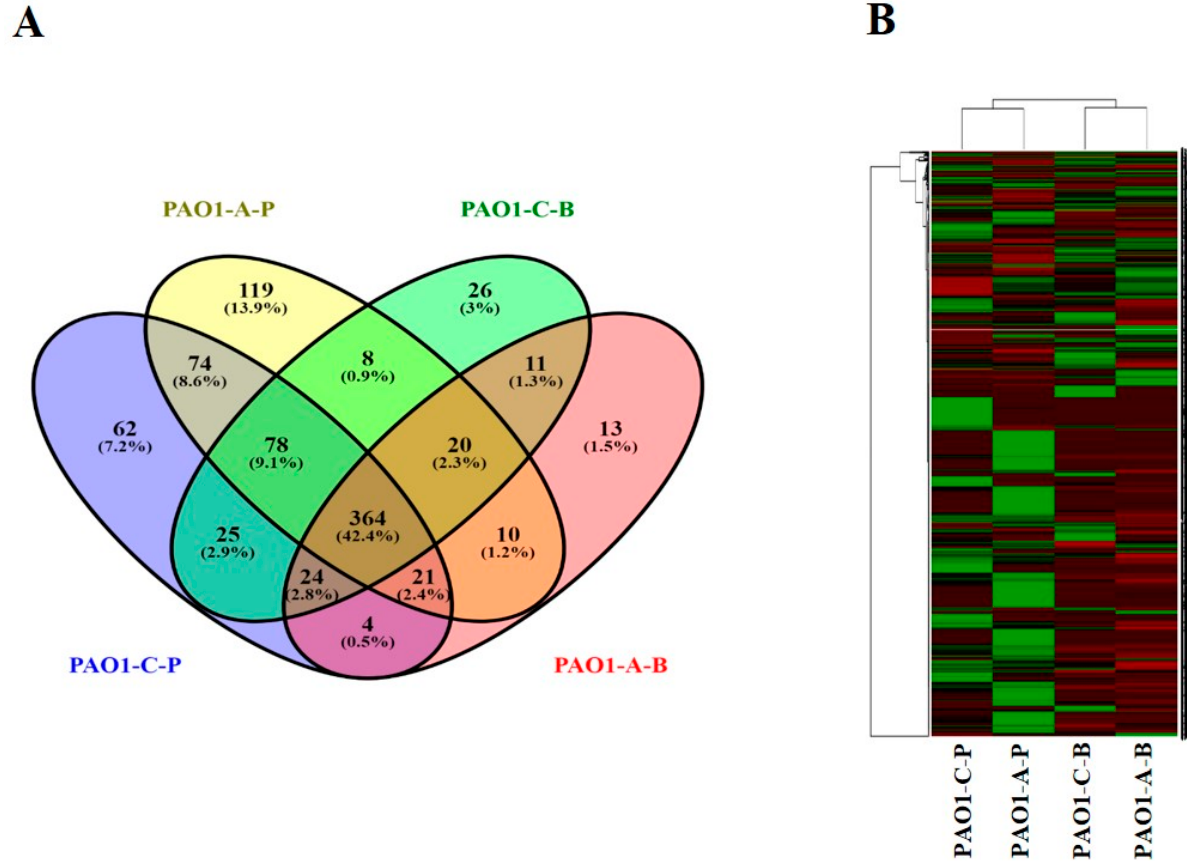
Figure 2. Venn diagram ( A ) and heatmap analysis ( B ) of P. aeruginosa PAO1 proteomic data. PAO1-C-P: planktonic cells grown with control catheters; PAO1-A-P: planktonic cells grown with antibiotic-coated catheters; PAO1-C-B: biofilm cells grown with control catheters; PAO1-A-B: biofilm cells grown with antibiotic-coated catheters.